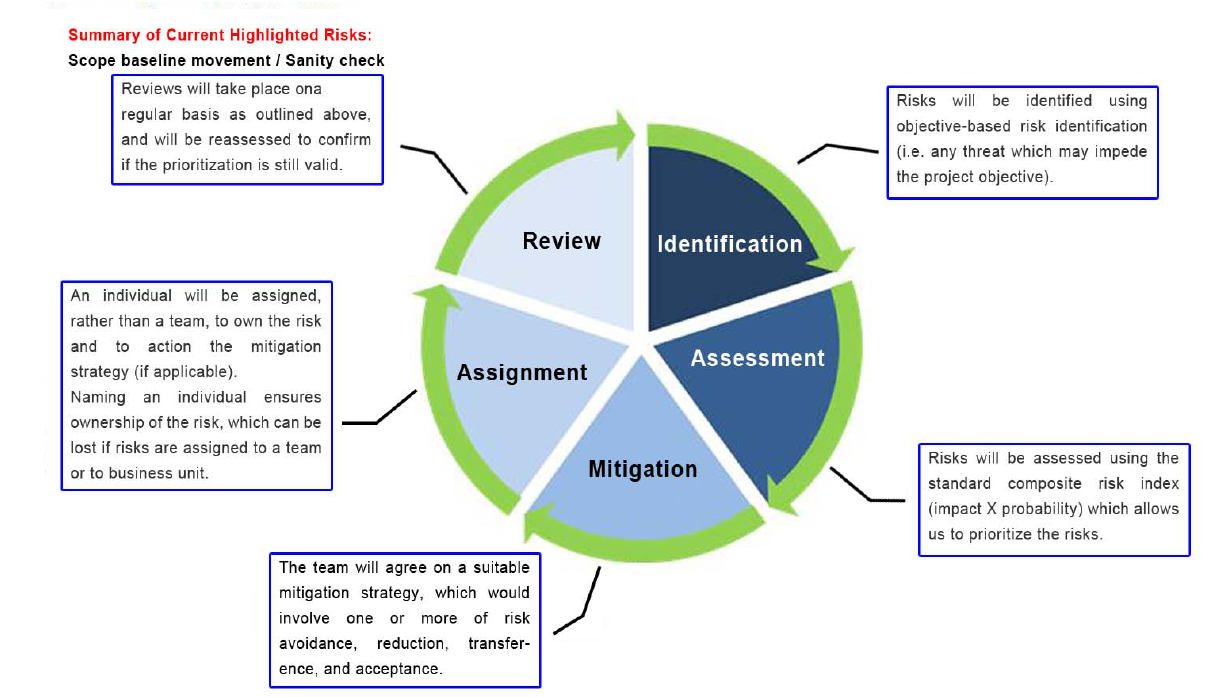
Figure 11. Risk Management